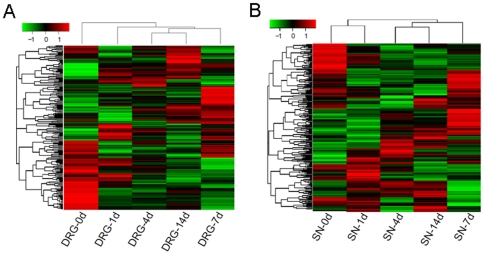
The heatmap for the miRNA with significant expression variance.A. Heatmap and cluster dendrogram of differentially expressed 201 miRNAs from DRG with or without injury. B. Heatmap and cluster dendrogram of differentially expressed 225 miRNAs from SN with or without injury. The color scale shown on the top illustrates the relative expression level of the indicated miRNA across all samples: red denotes expression >0 and green denotes expression <0.